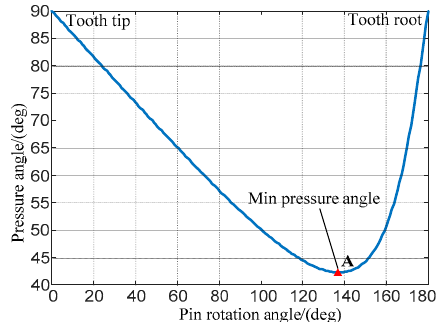
Table 1. Geometric parameters of the cycloid-pin gear.